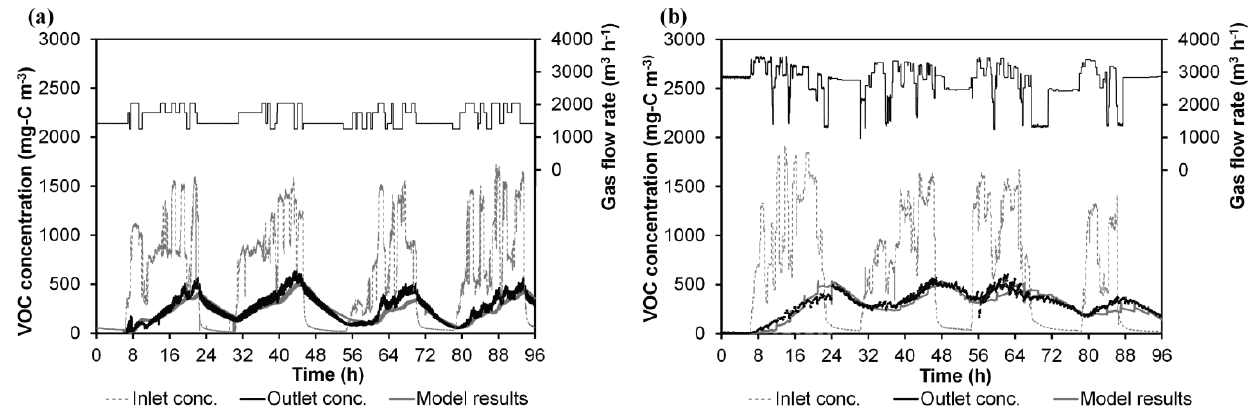
Figure 7. Experimental data and model results of the industrial BTF installed in a flexographic industry site: ( a ) Run 4 ( b ) Run